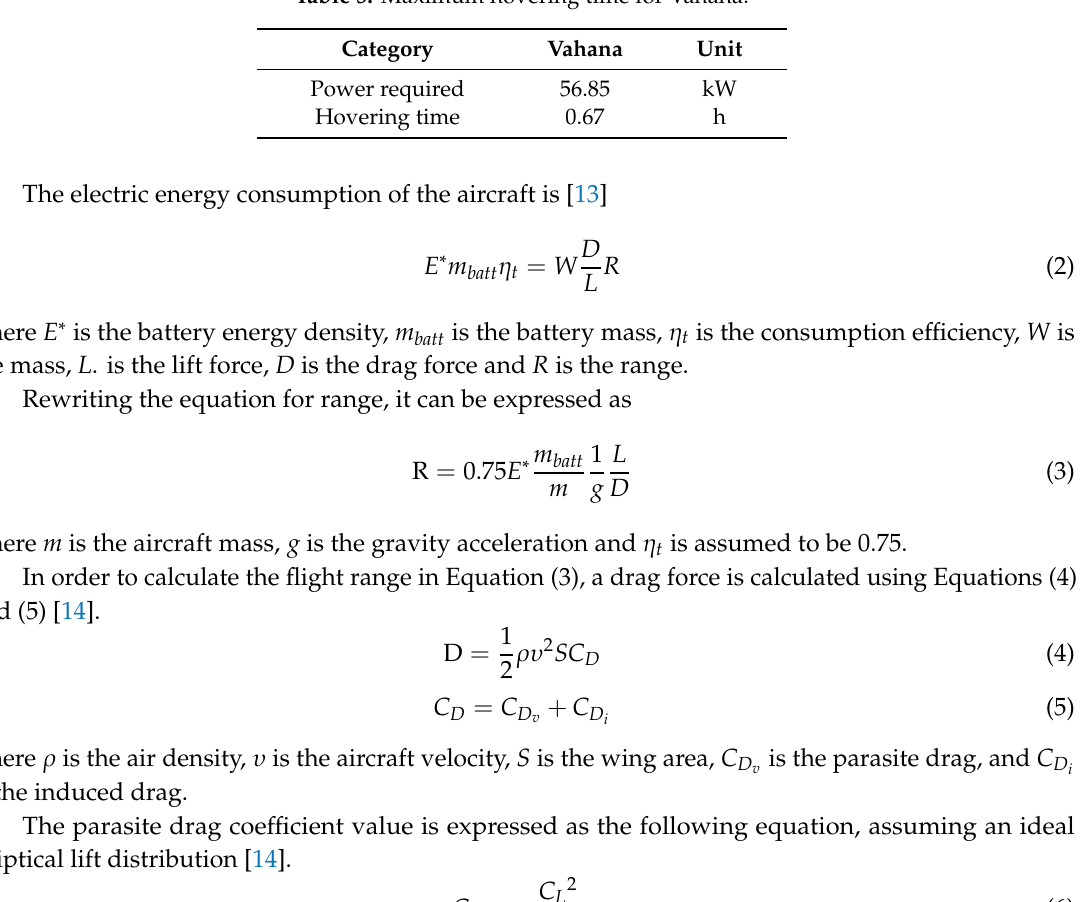
Table 5. Maximum hovering time for